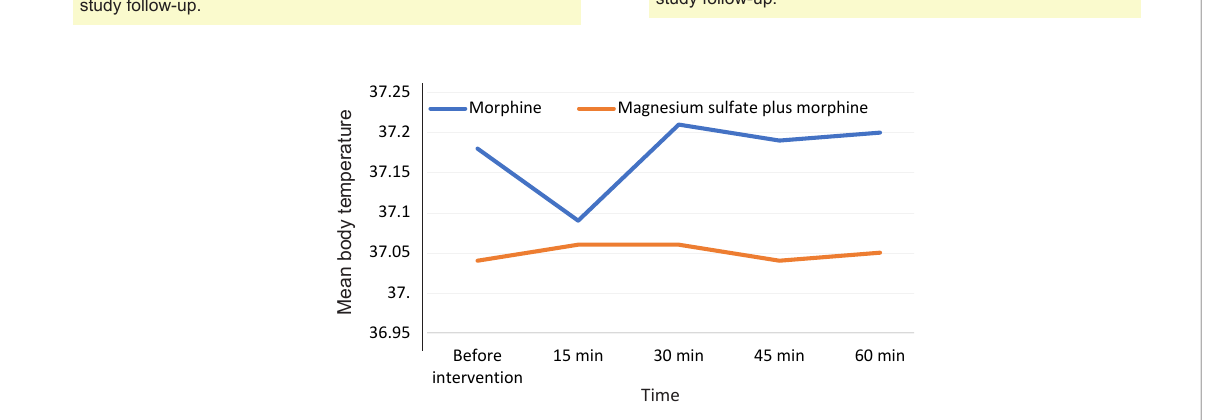
Figure 6 . The trend in mean number of breaths during the study